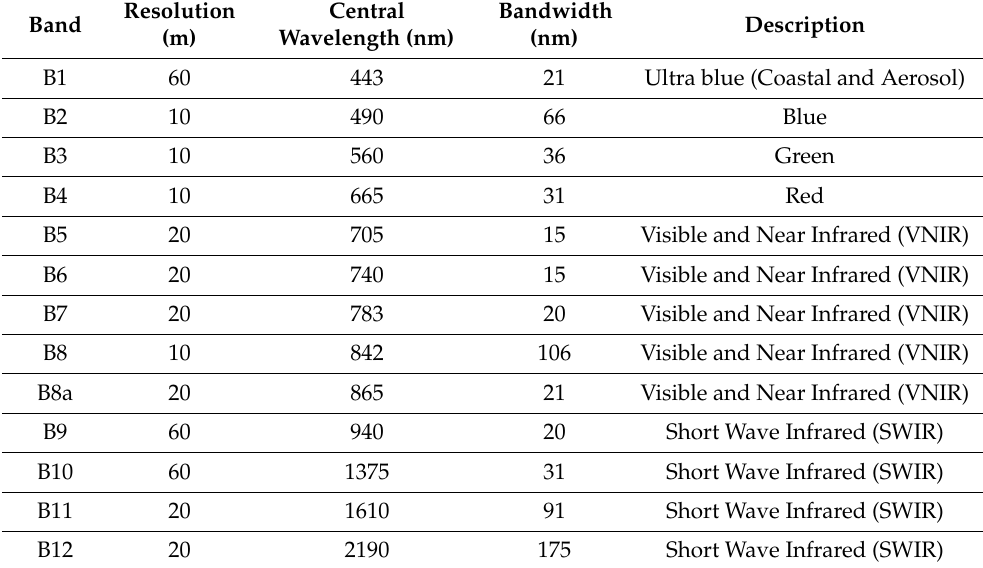
Table 1. Sentinel-2 band